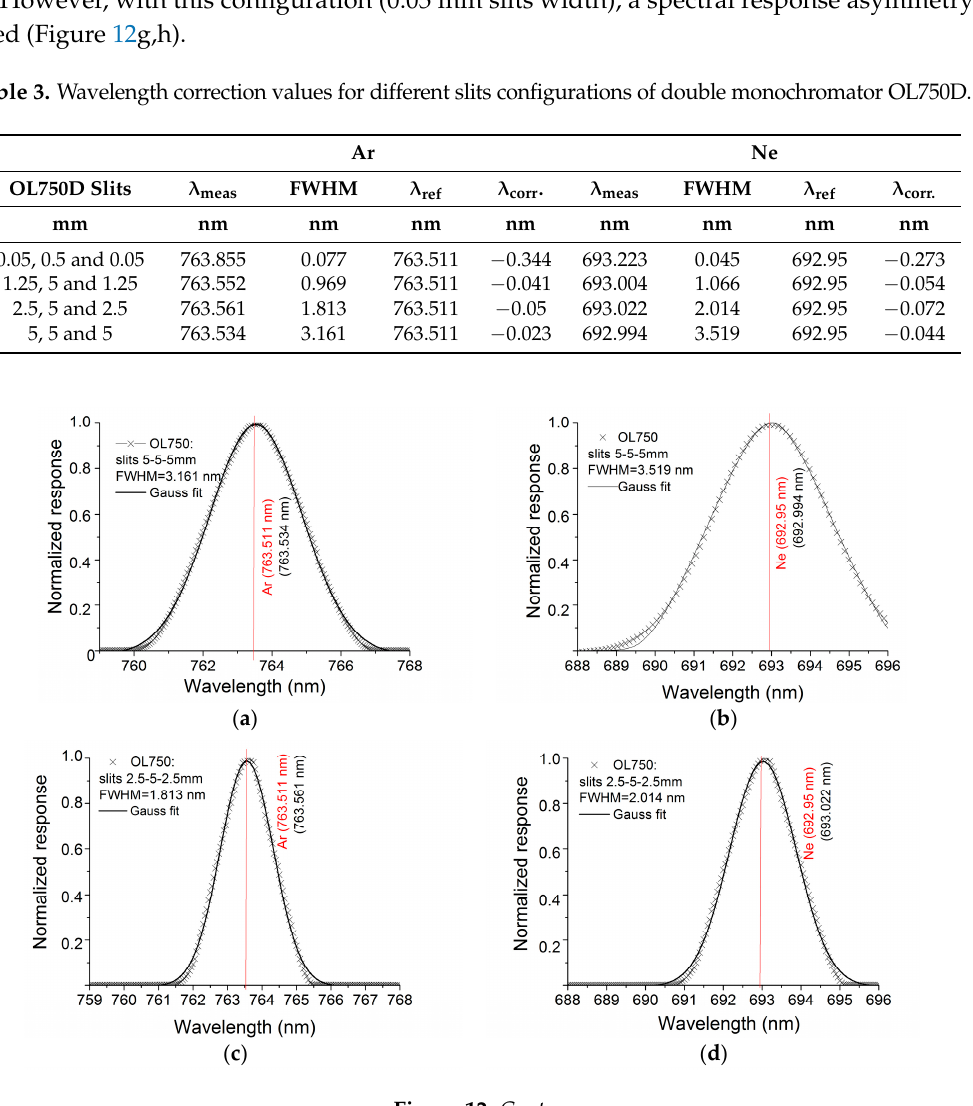
( h ) Figure 12 . Ne ( lef t) and Ar ( right ) lamps’ emission line measured with the double monochromator system OL 750D from Gooch & Housego and the corresponding standard absorption lines (red lines) [34] for slits’ combination at the monochromator entrance, middle and exit: ( a , b ) 5 mm, 5 mm and 5 mm; ( c , d ) 2.5 mm, 5 mm and 2.5 mm; ( e , f ) 1.25 mm, 5 mm and 1.25 mm; ( h , f ) 0.05 mm, 0.5 mm and 0.05 mm. The coloured lines represent the Gaussian fit applied to the multiple peaks under the envelope 3.2.2. Field Spectrometers Spectral Characterization with Monochromator Light Source The monochromator has the advantage of spectral resolution tuneability (Figure 12); therefore, the OL750D with a slit width of 1.25 nm can be used for reflectance spectrometers’ spectral calibration, and the 0.05 nm slit width can be used to calibrate the fluorescence spectrometers. Here, the results obtained for the QEP00114 spectrometer (DUT) spectral calibration to multiple wavelengths around 687 nm (corresponding to O2-A absorption line) and 760 nm (corresponding to O2-B line) using as the wavelength standard the OL750D with the 0.05 mm entrance and exit slits and 0.5 mm in the middle (Figure 13) are presented. The correction values vary along the scanning interval within less than 0.02 nm. The measured wavelength values for DUT represent the mean values of 10 acquired spectra, with a maximum spectral response Type A uncertainty of 0.12% along